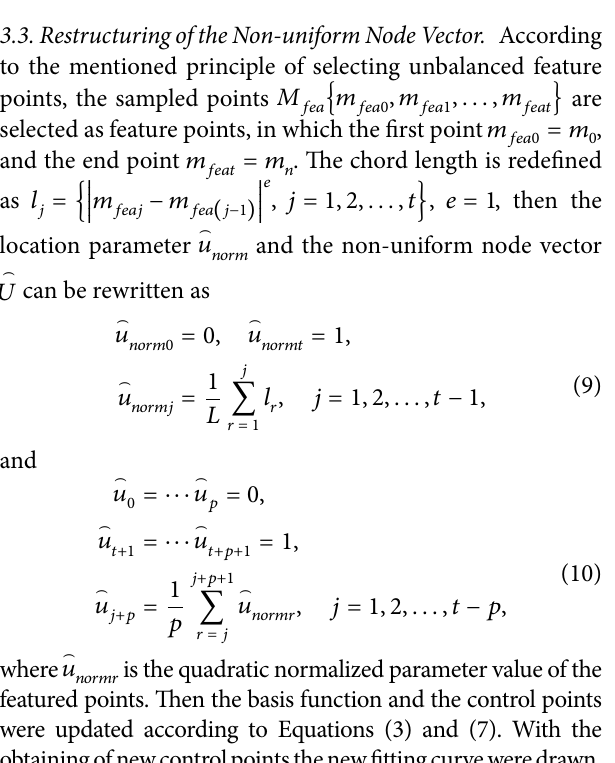
Figure 4: The distribution of